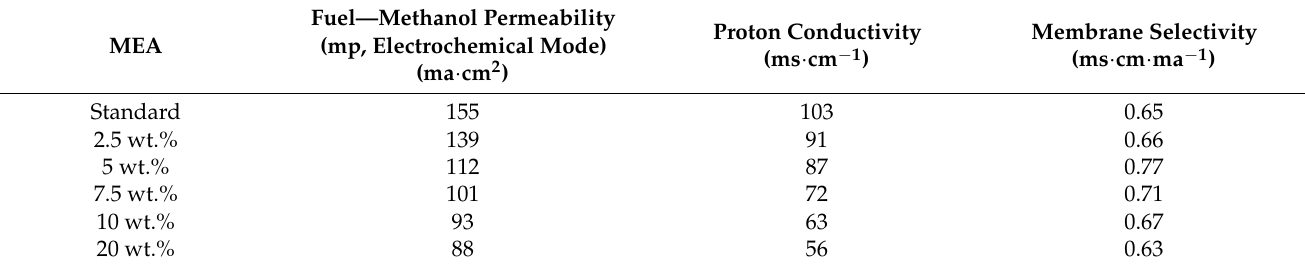
Table 2. Methanol permeability, proton conductivity and membrane selectivity values of standard and different graphene wt.%